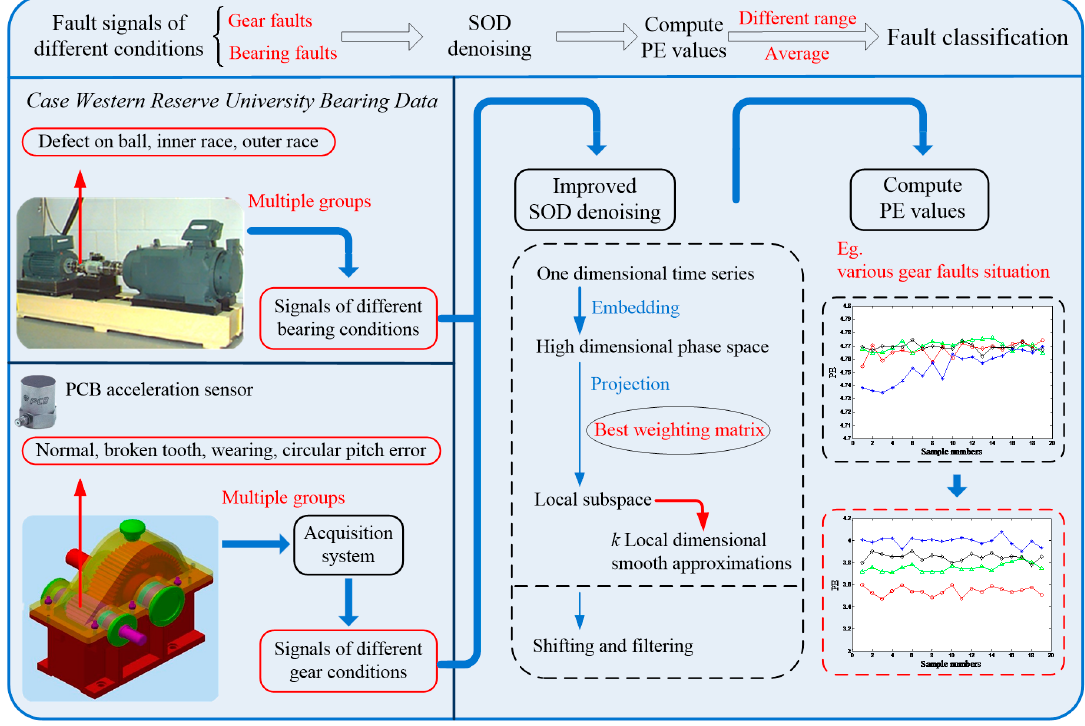
Figure 7. The proposed method based on smooth local subspace projection and permutation entropy (PE).